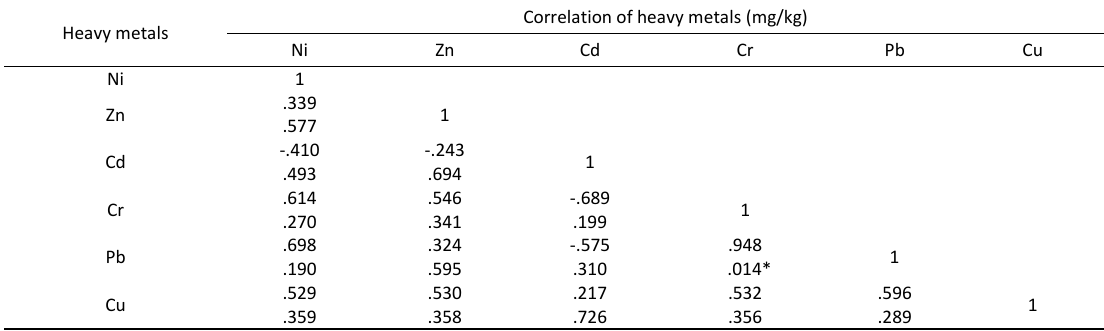
Table 4: Correlation between the selected heavy metals and Dumpsite at 0 – 20 cm Depth